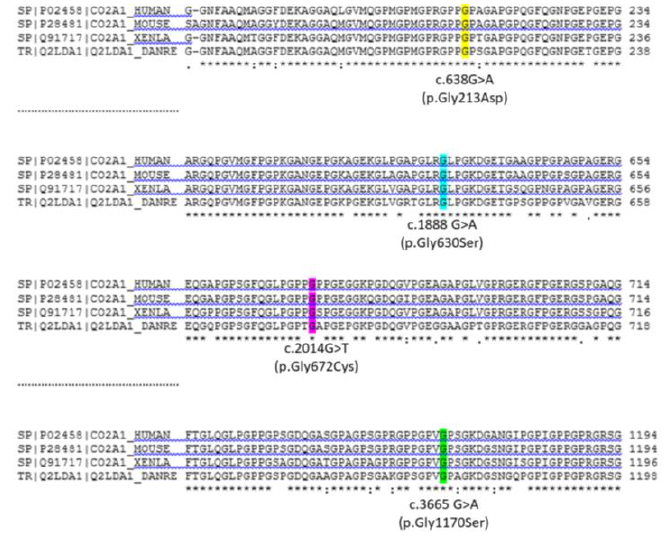
Figure 1. Protein sequence alignment of COL2A1 protein. COL2A1 proteins show high conservation of the primary structure among distant species. The figure shows CLUSTAL OMEGA (1.2.4) multiple sequence alignment of the regions of COL2A1 protein of different organisms: Human, Mus musculus, Xenopus laevis, and Danio rerio [Uniprot identifiers: P02458, P28481, Q91717, Q2LDA, respectively]. Highlighted amino acids show the mutations found in Perthes patients. c.638 G > A (p.Gly213Asp) (exon 9); c.2014 G > T (p.Gly672Cys) (exon 31) (NM_001844.5) [50]; c.1888 G > A (p.Gly630Ser) (exon 29) (NM_033150.3) [51]; c.3665 G > A (p.Gly1170Ser) (exon 50) (NM_033150.3) [48,49]. The alignment of the whole protein sequence is given in Supplementary